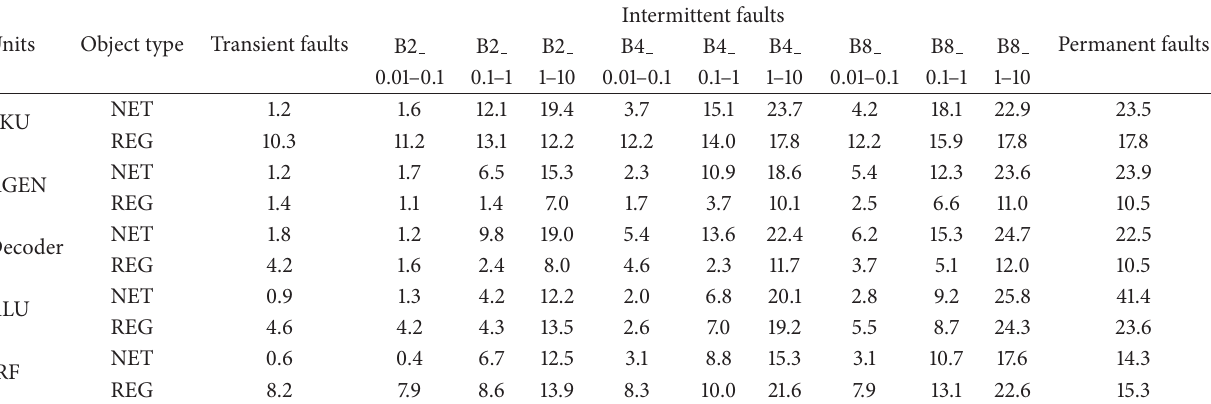
Table 4: Sensitivity per unit